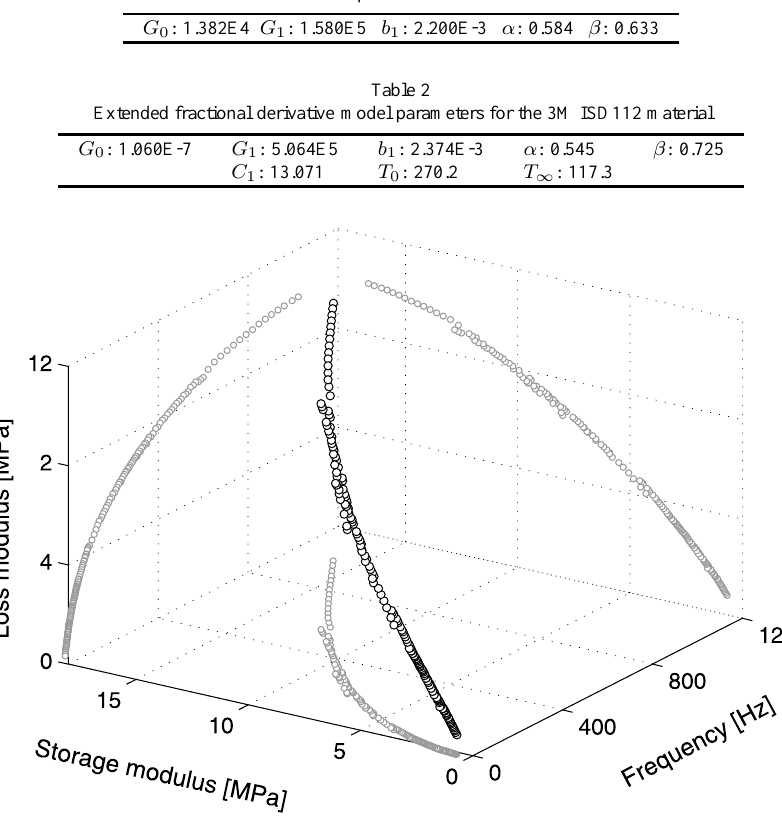
Fig. 5. Master curve of the experimental data (reference temperature 6.8 ◦